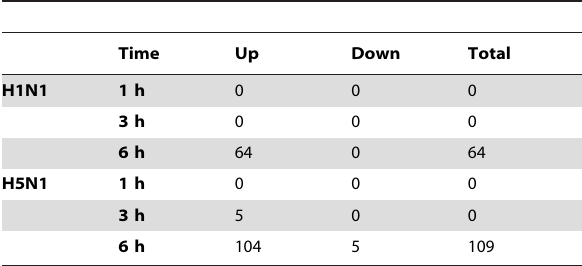
Table 1. Summary of genes differentially expressed in response to H1N1 and H5N1